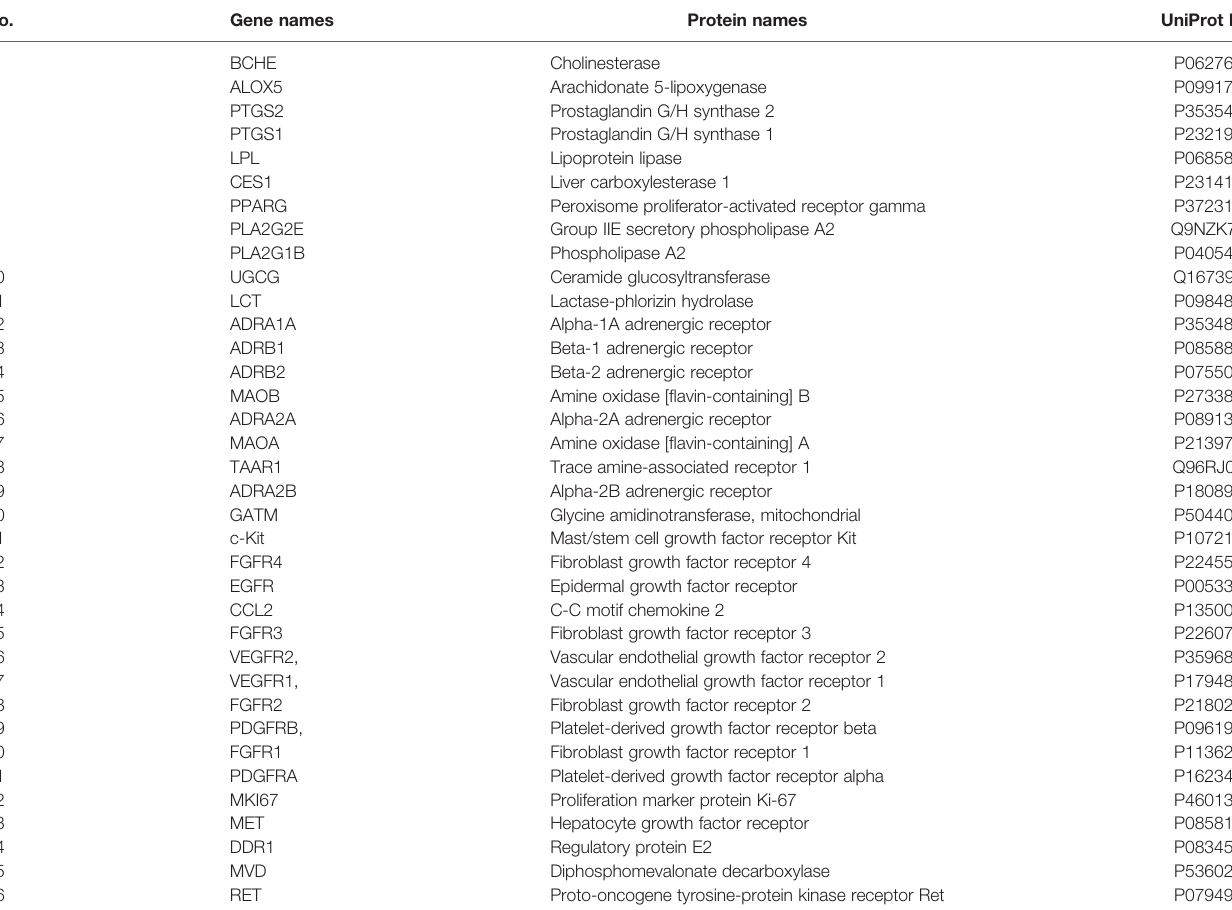
TABLE 2 | Key direct targets of anlotinib combined with XHW in the treatment of lung cancer.